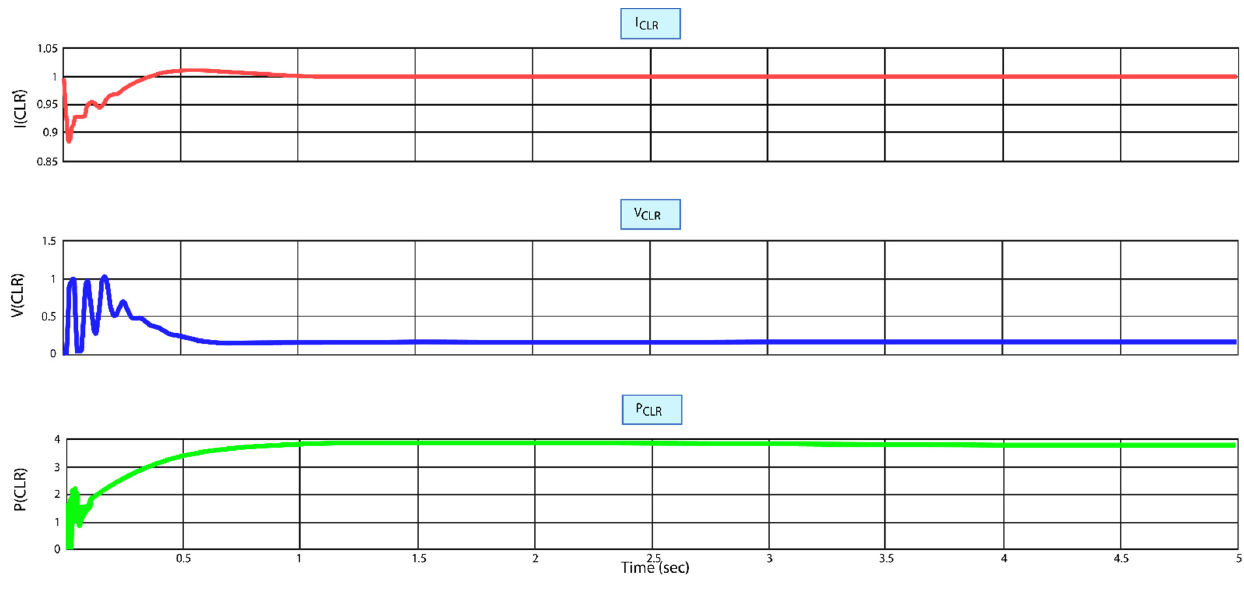
Figure 11. I, V, and P waveforms due to the CLR’s inductance (pu). Following a DC fault, the VCLR rapidly increases to the peak positive value, lowers to the peak negative value, passes through zero, and then increases again. It is hypothe- sised that variations in the primary transformer winding (IN1) are linked to the resistance created by the superconducting element (RSC2). As seen in Figure 6, IfCL is distributed predominantly between the primary winding of the transformer (IN1) and the supercon- ducting element RSC1 as the current in RSC2 approaches zero (the “4” point). While RSC1 and RSC2 resistances are decreasing, this is still the case (ISC1). Power waveforms of the RSC1 and RSC2 are shown in Figure 11 due to the inductance of the CLR. As the DC SFCL inductance increases from 6.6 to 10 mH, the RSC2 superconducting element’s peak instan- taneous power (PSC2) takes longer to reach its first peak value. Similar to how the CLR with resistance increases, the power loads on RSC1 (PSC1) and RSC2 (PSC2) are seen to be increased in Figure 6 (higher). The power load in the RSC2 superconducting element (PSC2) disappears almost instantaneously when VSC2 gets to zero, as shown in Figure 11, independent of the value of the CLR inductance. 4.2. IEEE-39 Bus System for Testing Simulations and data collection for this investigation were carried out in MATLAB. The IEEE 39 bus New England test system was used to verify the accuracy of the sug- gested technique (depicted in Figure 13). Buses 17, 21, 26, and 28 have all had three-phase short circuits, however, none of these have been replicated in this simulation. Due to the critical nature of transient performance, we restrict our investigation to the lines con- nected to the aforementioned four buses. The researchers concluded that SFCLs should not be placed at the intersections of lines 18-17, 17-16, 27-17, 21-16, 22-21, 26-25, 29-26, 27- 26, 28-26, and 29-28. Table 4 displays a compilation of these line lengths. One method of determining a bus’s annual fault rate is dividing it by the sum of the fault rates of the lines that feed into it. Fault rates for four buses are displayed in Table 5 along with the occur- rence rate of these catastrophic events. Simulation parameters are displayed in Table 6 along with parameter values.